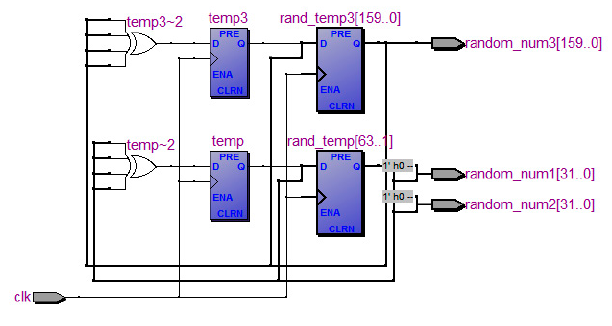
Figure 8. RTL-schematic diagram of the random generator.